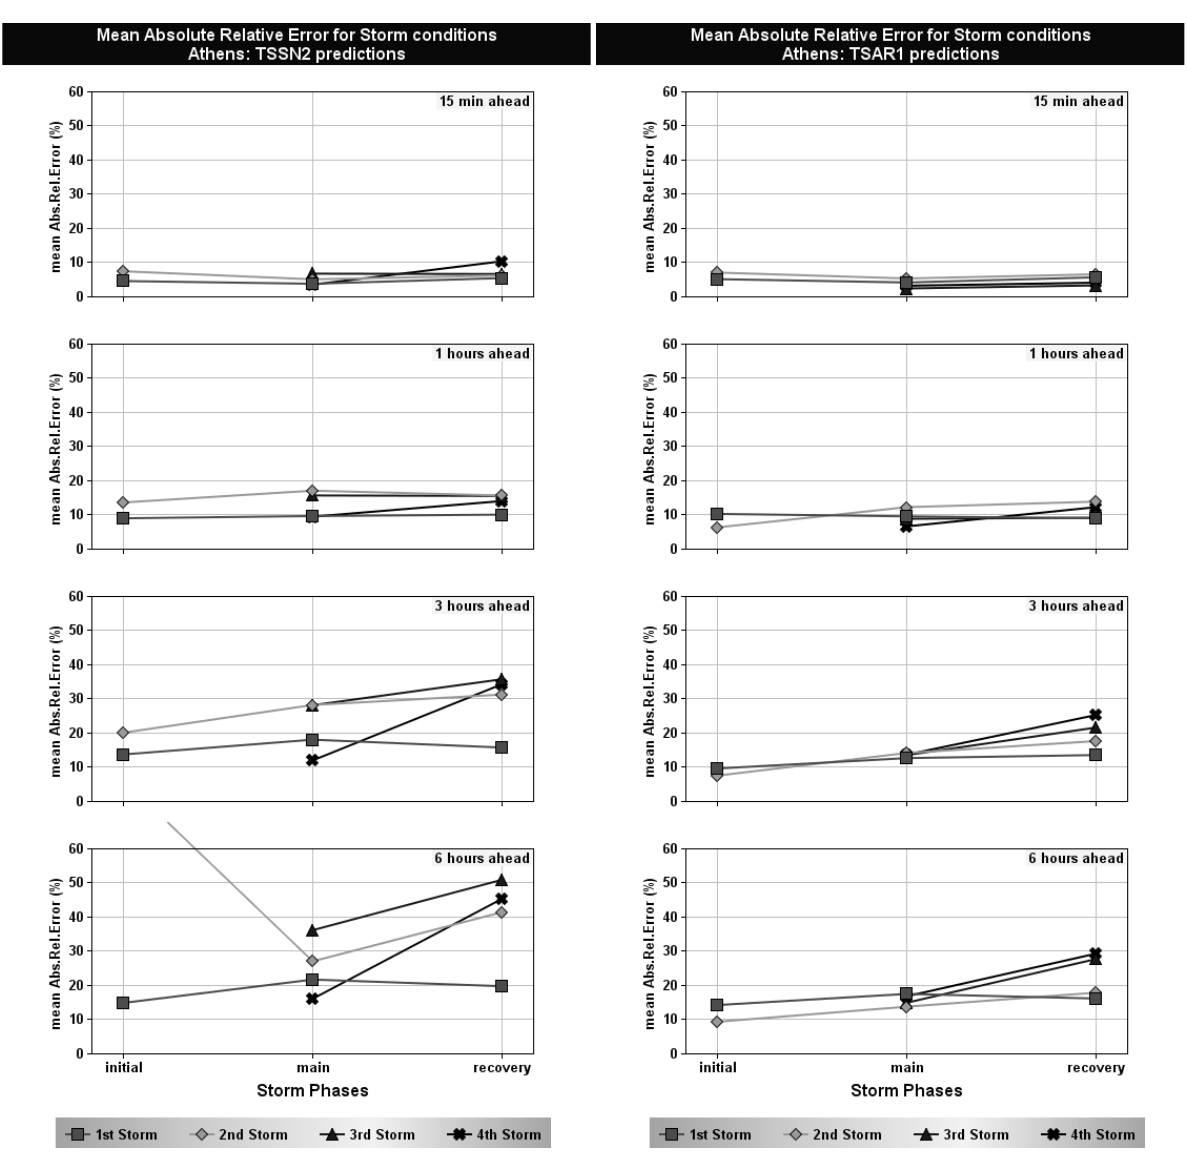
Fig. 5. The mean absolute relative error values for Athens location and for prediction windows 15min, 1h, 3h and 6h calculated over the three phases of each storm (initial, main and recovery) using the prediction results of the three methods TSNN2 (left column), TSAR1 (right column), TSAR2 (continued in the next